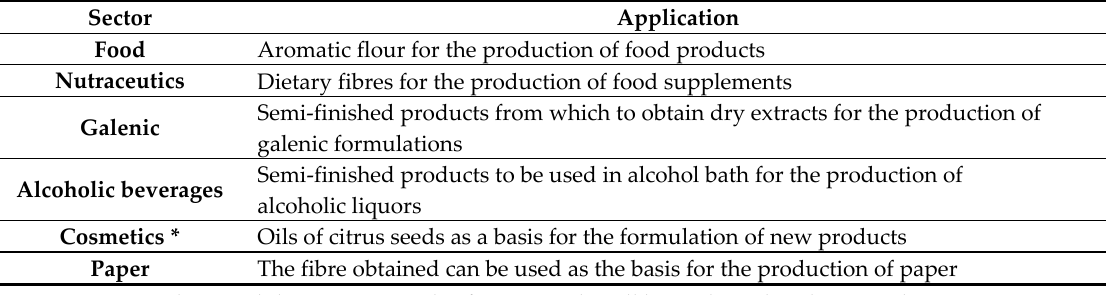
Table 2. Potential outlet markets of AMD